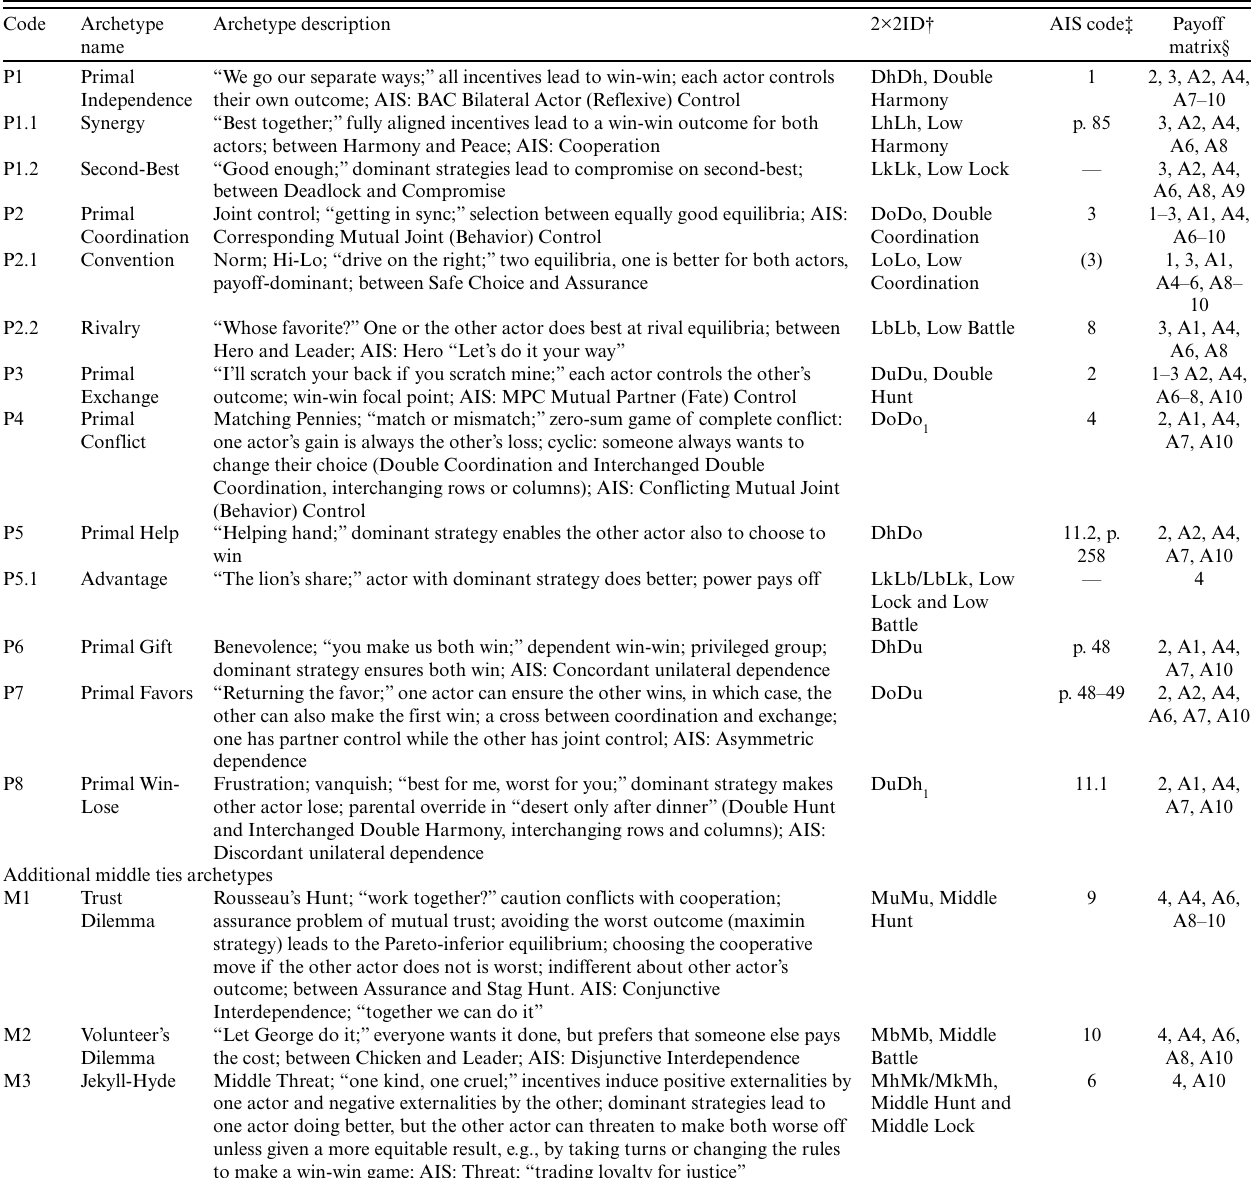
Table 2. Primal and intermediate